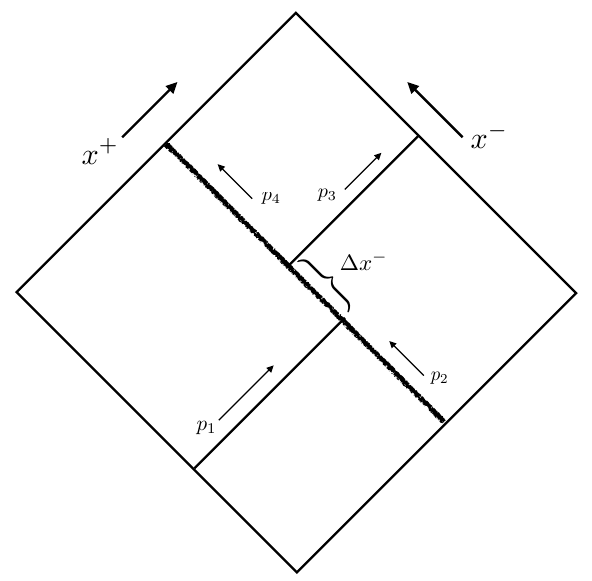
Figure 1 . The shockwave geometry and its connection to scattering. The shockwave travels in the x (cid:0) direction. It is traversed by a particle traveling in the x + direction which experiences a time delay (cid:1) x (cid:0) as it crosses the